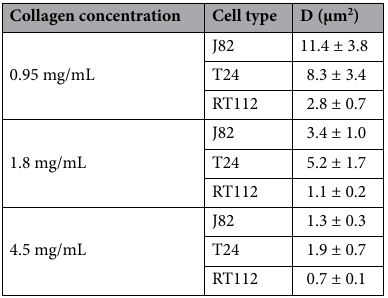
Table 1. Mean values of the diffusivity (in μm 2 ) ± standard error of the mean.